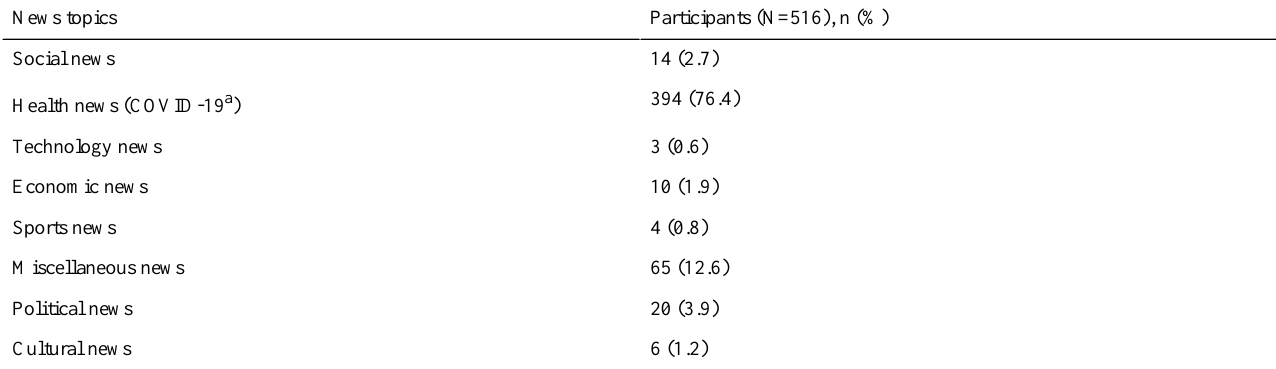
Table 3. The news topics classifications.